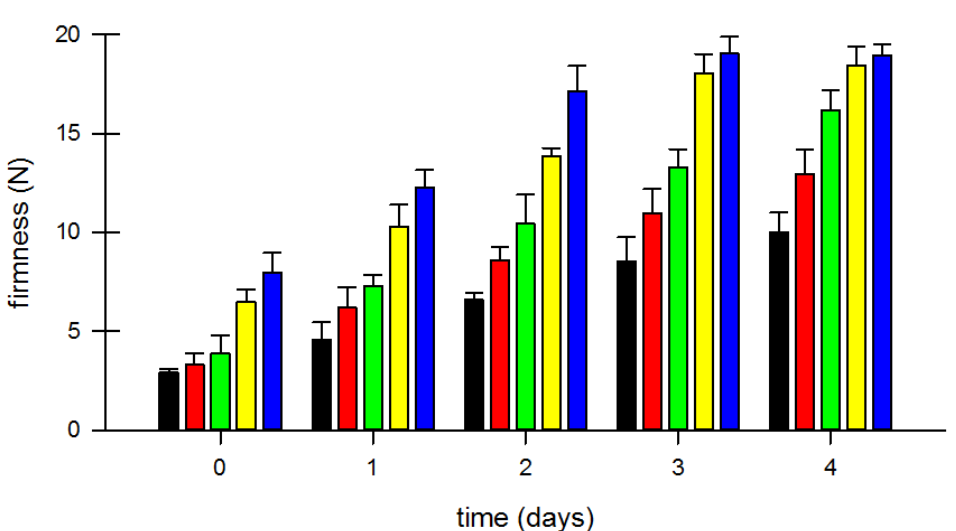
Figure 3. The impact of the inclusion of fermented brewers spent grain on the firmness of sourdough bread over time. Black bars represent the control sourdough bread with no FBSG; red bars represent the sourdough bread with 5% FBSG; green bars represent the sourdough bread with 10% FBSG; yellow bars represent the sourdough bread with 15% FBSG; blue bars represent the sourdough bread with 20% FBSG. All data shown are the average and standard deviation (error bars) of triplicate determinations. Zero time (0) indicates the day of sourdough bread production.